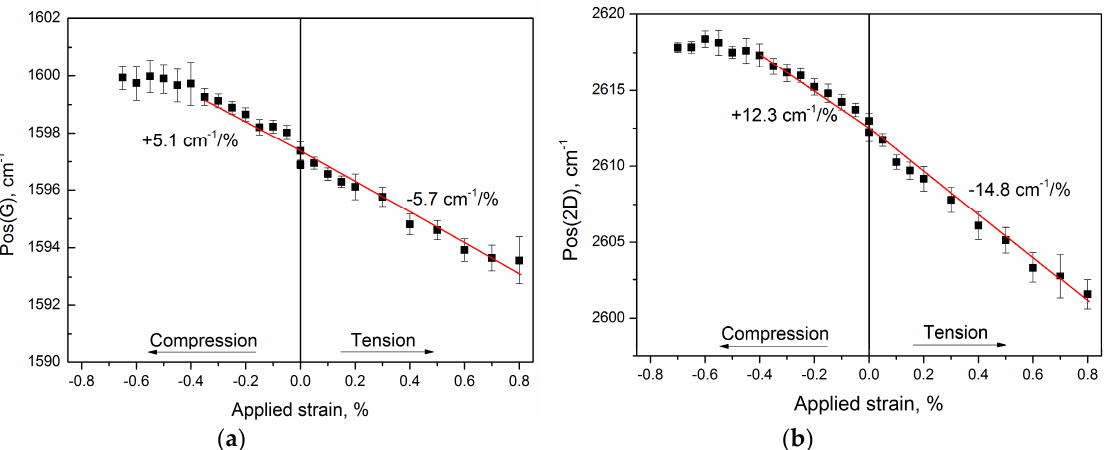
Figure 6. Position of G ( a ) and 2D ( b ) peaks versus strain for the embedded CVD graphene micro-ribbons. Solid lines represent fits to the experimental data.